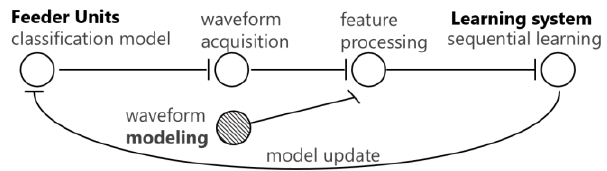
Figure 1. DL waveform feature learning model process. Figur 1. DL condition recognition model process setup with modeling and acquiring waveforms for learning system